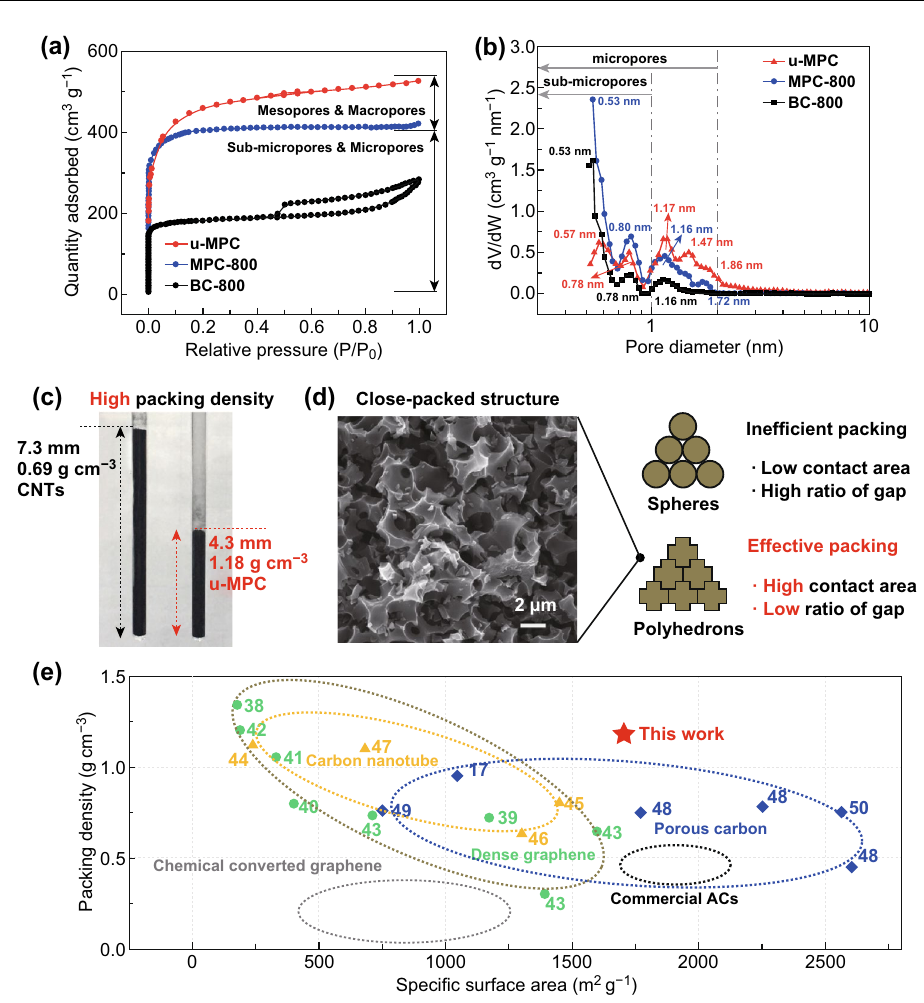
Fig. 4 Pore parameter and packing density of u‑MPC as compared with counterparts. a Nitrogen adsorption/desorption isotherms. b Pore size distribution. c Packing density as compared with CNTs. d Morphology of carbon particles and schematic illustration of packing structure with various particles. e Packing density versus specific surface area as compared with other